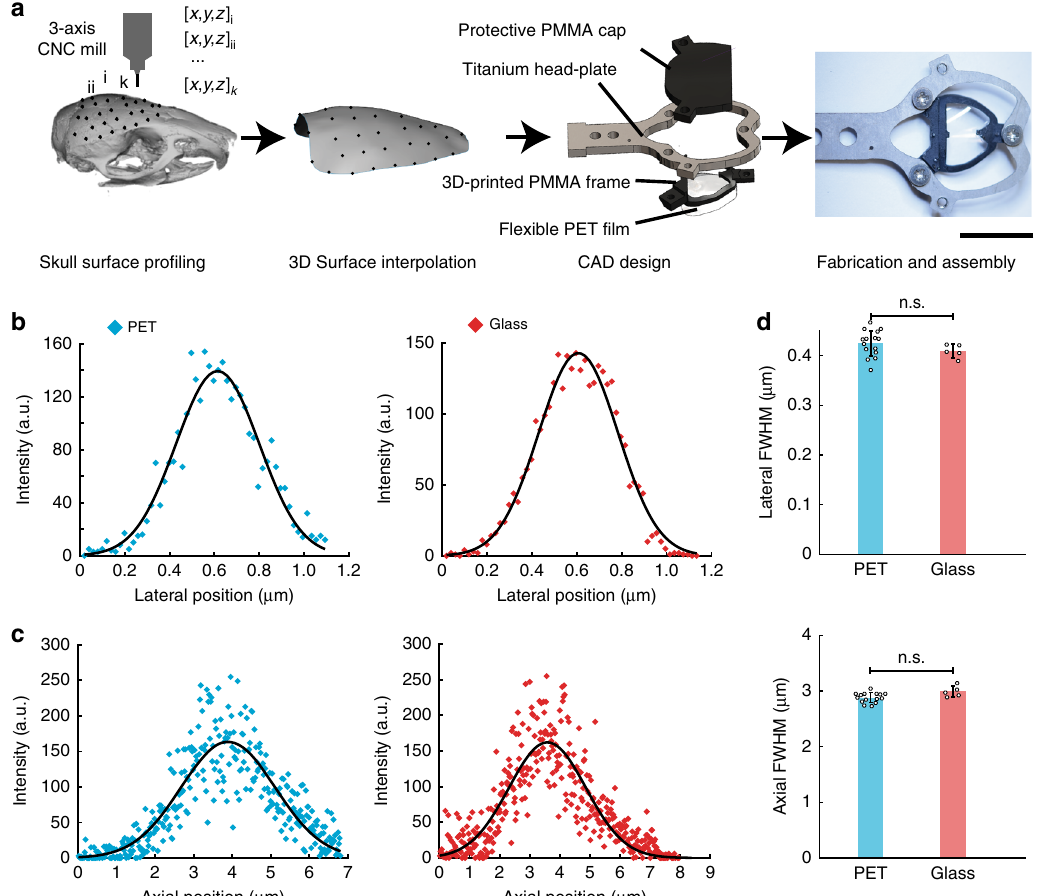
Fig. 1 Digitally generating See-Shells. a The dorsal surface of the mouse skull is pro fi led using a computer numerical controlled mill integrated into the stereotaxic instrument. This skull surface pro fi le is used to interpolate a three-dimensional (3D) surface. The 3D surface is used as a template to design morphologically conformant transparent implants (See-Shells), consisting of a 3D-printed polymethylmethacrylate (PMMA) frame, onto which a thin, optically clear and fl exible polyethylene terephthalate (PET) fi lm is bonded. A titanium head-plate fastened to the frame provides mechanical support for head- fi xation and a 3D-printed cap protects the implant and underlying brain tissue. Photograph of a fully fabricated and assembled See-Shell is illustrated on the right. Scale bar indicates 1 cm. b Lateral point spread functions (PSFs) of 200 nm yellow green (YG) fl uorescent beads imaged with a ×40 (1.15 NA) objective through the PET fi lm (left) and glass coverslip (right). Black curved line indicates Gaussian fi t to the intensity measurements. c Axial PSFs of 200 nm YG fl uorescent beads imaged with the same objective as in b , through the PET fi lm (left) and glass coverslip (right). Black curved line indicates Gaussian fi t to the intensity measurements. d Bar plots overlaid with the dot plots of lateral (top) and axial (bottom) full width at half maximum (FWHM) of the PSF measured through the PET fi lm and #1.5 glass coverslip ( n = 15 measurements in each of three PET fi lms, and n = 5 measurements in glass coverslip). a.u. arbitrary unit, n.s. not signi fi cant. Error bars indicate Multi-photon and time-correlated single-photon counting (TCSPC) based fl uorescence-lifetime imaging microscopy (FLIM) of fl uorescent yellow-green (YG) beads was performed to assess whether the PET fi lm introduces changes in light intensity or fl uorescence lifetime, respectively. While the present application for See-Shells is fl uorescence intensity measurements, FLIM has an additional utility due its sensitivity to changes in the tissue microenvironment and sample conditions without being affected by changes in fl uorophore concentration. Concerning light intensity, 2P imaging of YG beads through the PET fi lm required 1 – 2% higher gain settings on the photomultiplier tube (PMT)